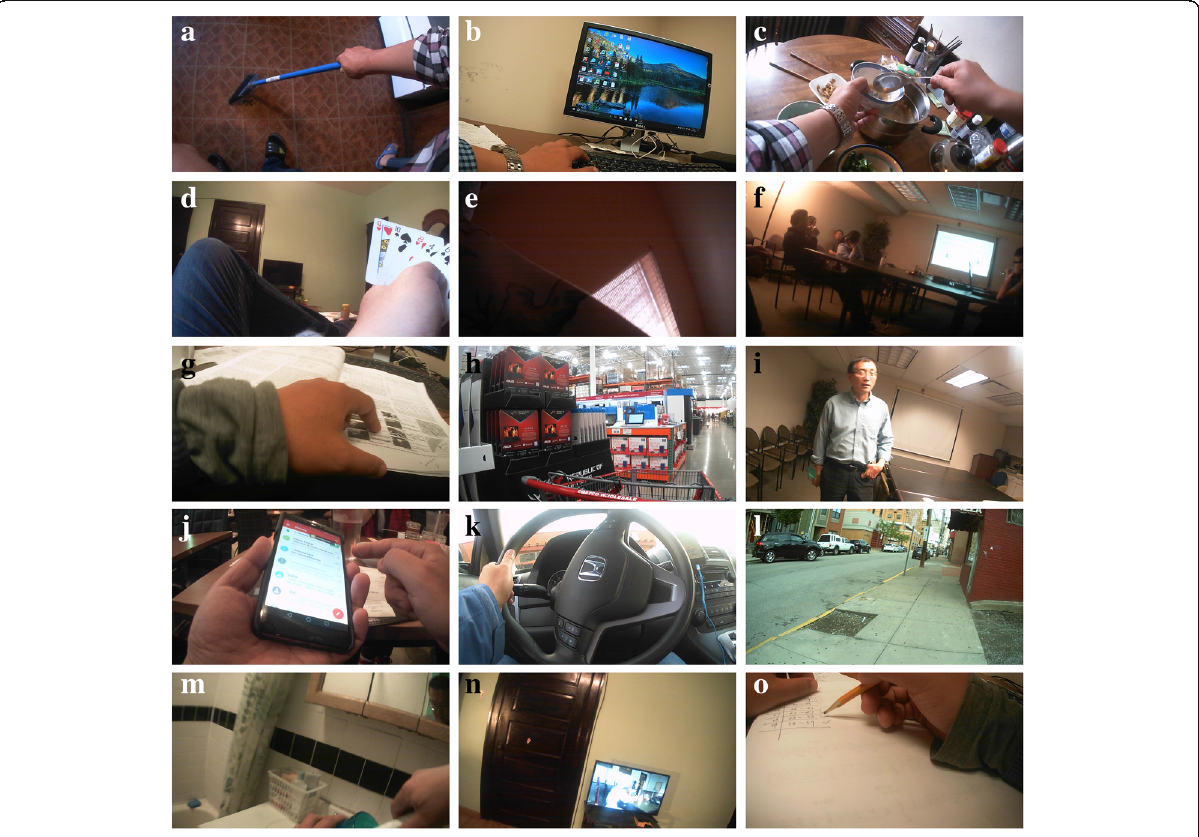
Fig. 6 The sample image of each activity in the training set. Images a through o correspond to “ cleaning, ” “ computer use, ” “ eating, ” “ entertainment, ” “ lying down, ” “ meeting, ” “ reading, ” “ shopping, ” “ talking, ” “ telephone use, ” “ transportation ” (driving), “ walking outside, ” “ washing up, ” “ watching TV, ” and “ writing, ”